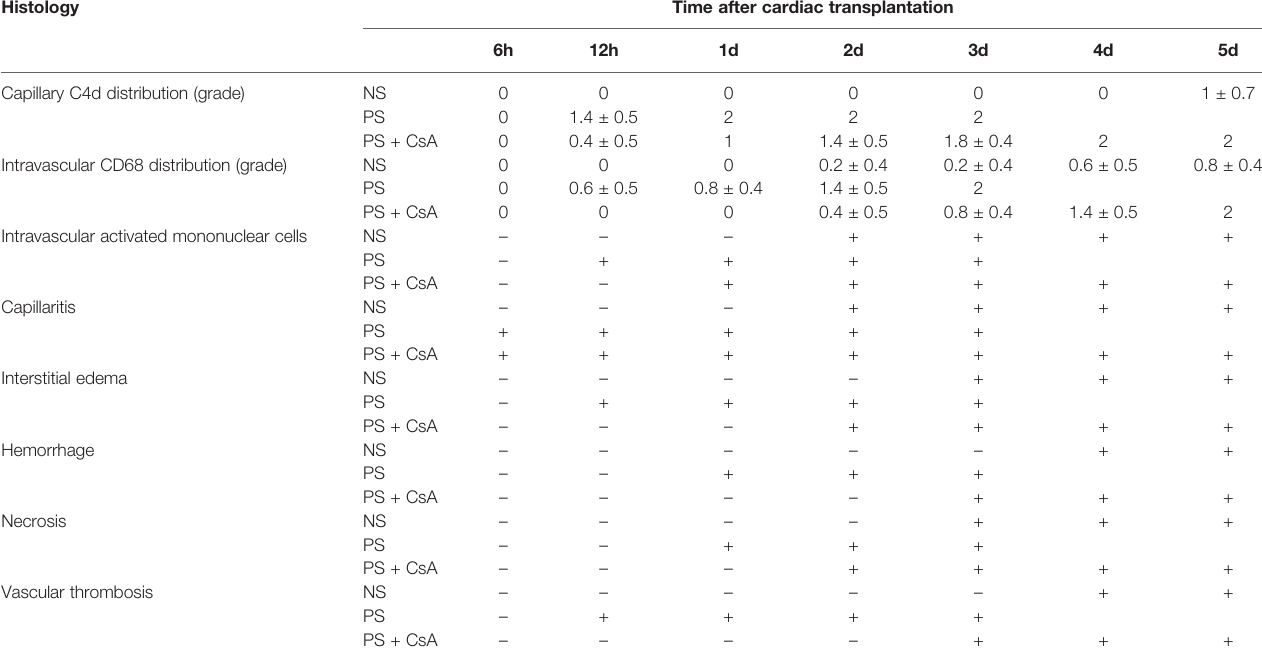
TABLE 2 | Histological evaluation according to the criteria of ISHLT. Histology Time after cardiac transplantation